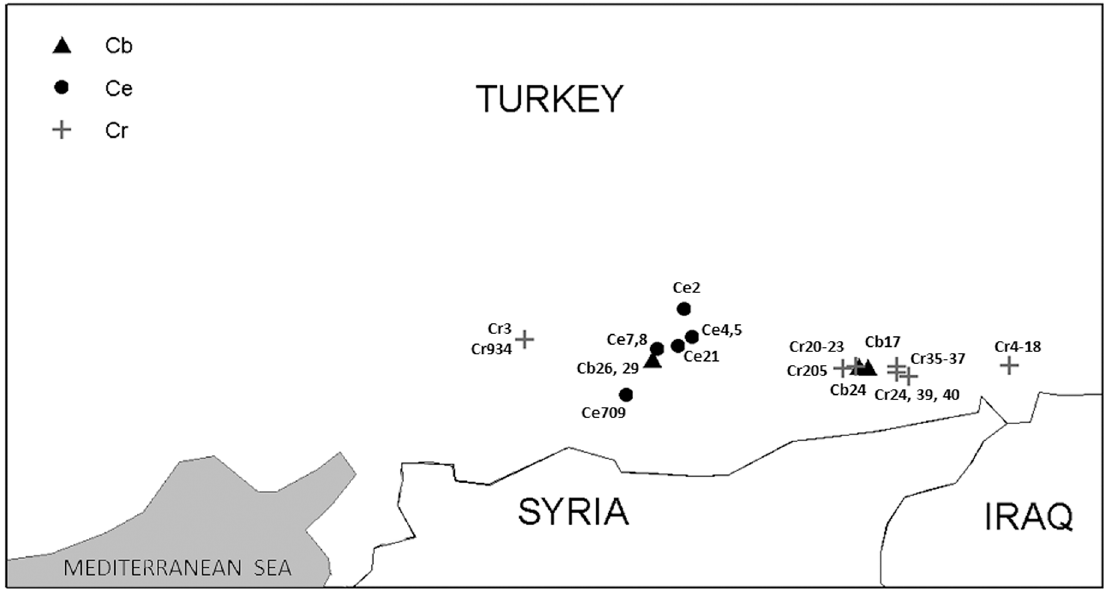
Fig 1. Geographical locations of the sampled wild populations employed in this